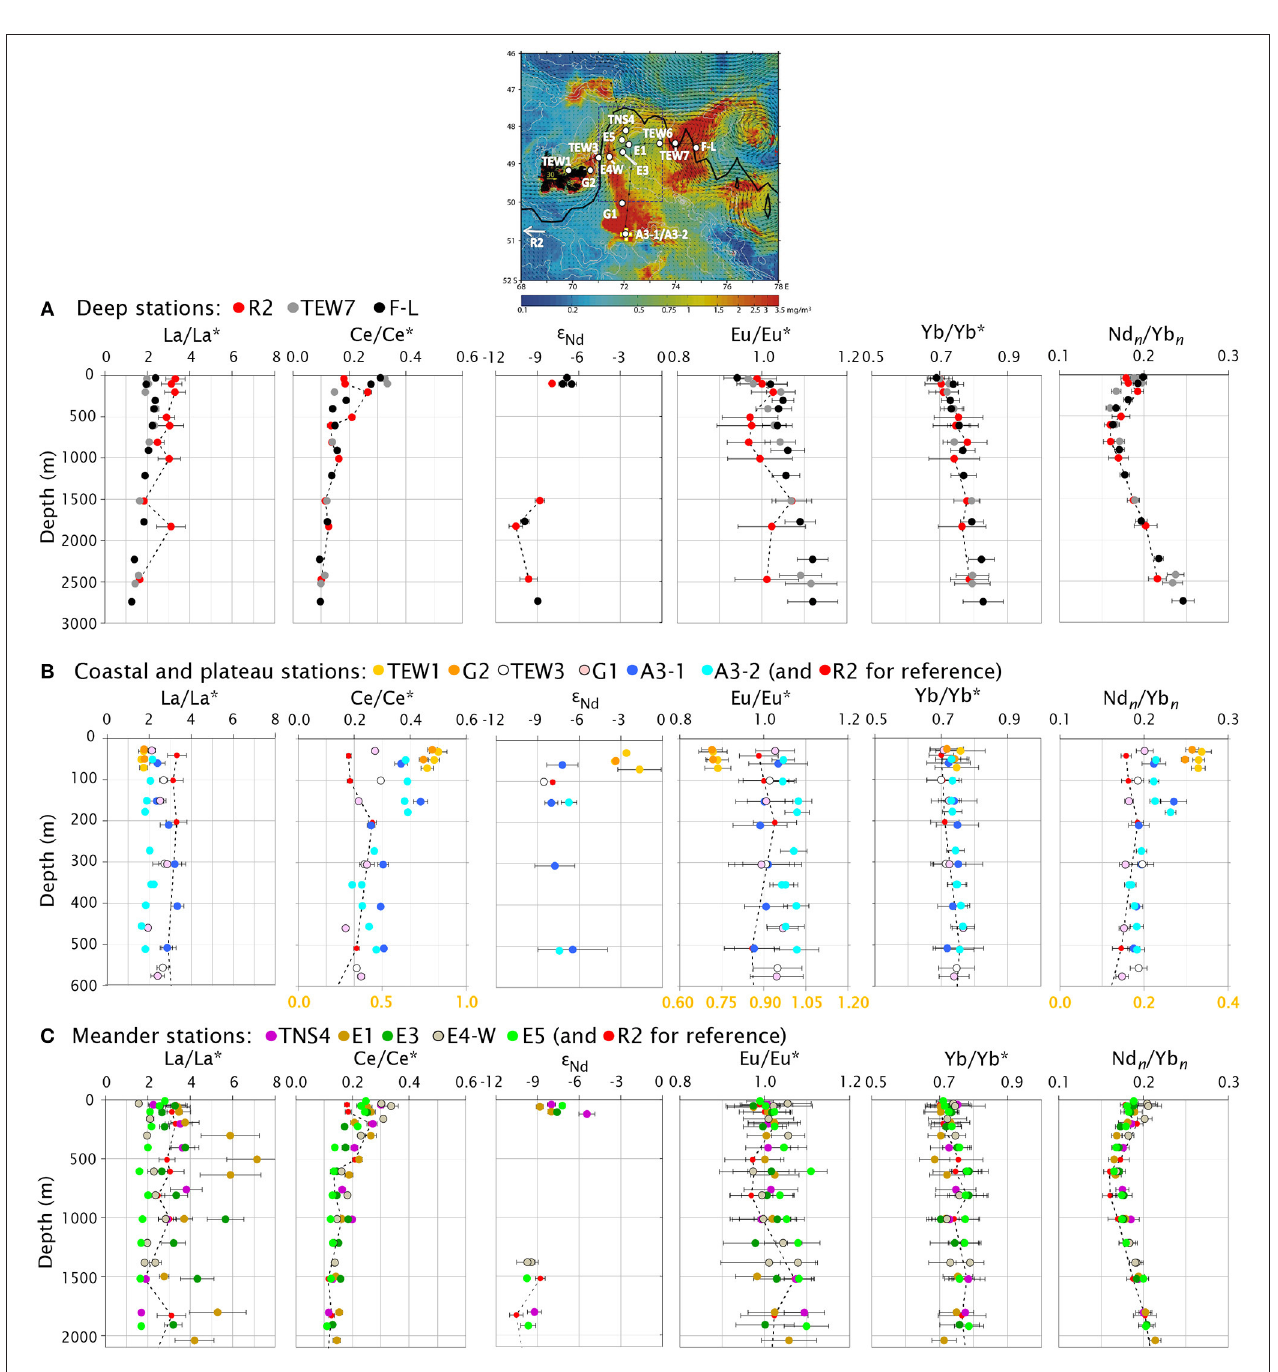
FIGURE 5 | Vertical profiles of the anomalies of La (La/La*), Ce (Ce/Ce*), Eu (Eu/Eu*), and Yb (Yb/Yb*), calculated following Garcia-Solsona et al. [2014; Equations (1–4) in the text], and of Nd n /Yb n , from the PAAS-normalized REE patterns shown in Figure 4. The vertical profiles of the dissolved Nd isotopic composition, expressed as ε Nd , are also shown. These six parameters complement the vertical profiles of the concentrations shown in Figure 3 . As in Figures 3 , 4 : (A) deep stations R2, TEW7, and F-L, in the vicinity of the PF; (B) coastal and plateau stations TEW1, G2, TEW3, G1, A3-1, and A3-2; and (C) stations located in the meander area TNS4, E1, E3, E4-W, and E5. Also, as in Figures 3 and 4, the data of station R2 are reported for comparison in (B,C) (profile represented by the red dots and gray dashed line). Note the larger scale of Ce/Ce*, of Eu/Eu*, and of Nd n /Yb n associated with the coastal sample parameters of stations TEW1 and G2 [yellow secondary horizontal axis in (B) ]. Error bars are given for each parameter, representing the TIMS method uncertainty (2 σ ) for ε Nd and the uncertainty propagation from the anomaly Equations (1–4) for the other profiles (see the Supplementary Material for details).